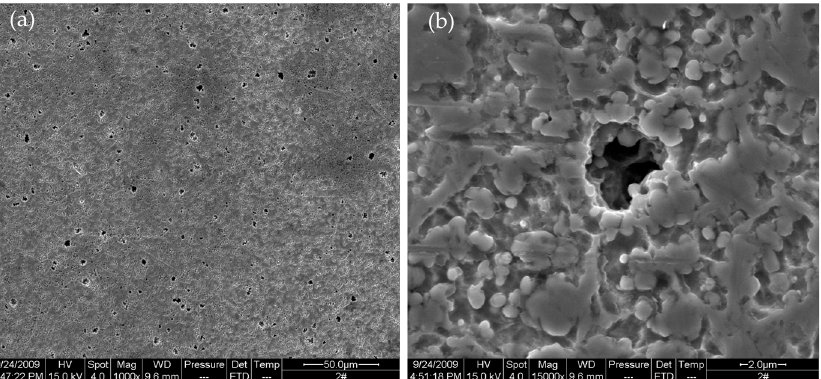
Figure 3. Pitting damage micromorphology ( a ) SEM image of the rolling elements in the bearing with the passage of the electrical current; ( b ) the magnified image of a typical pit [13].